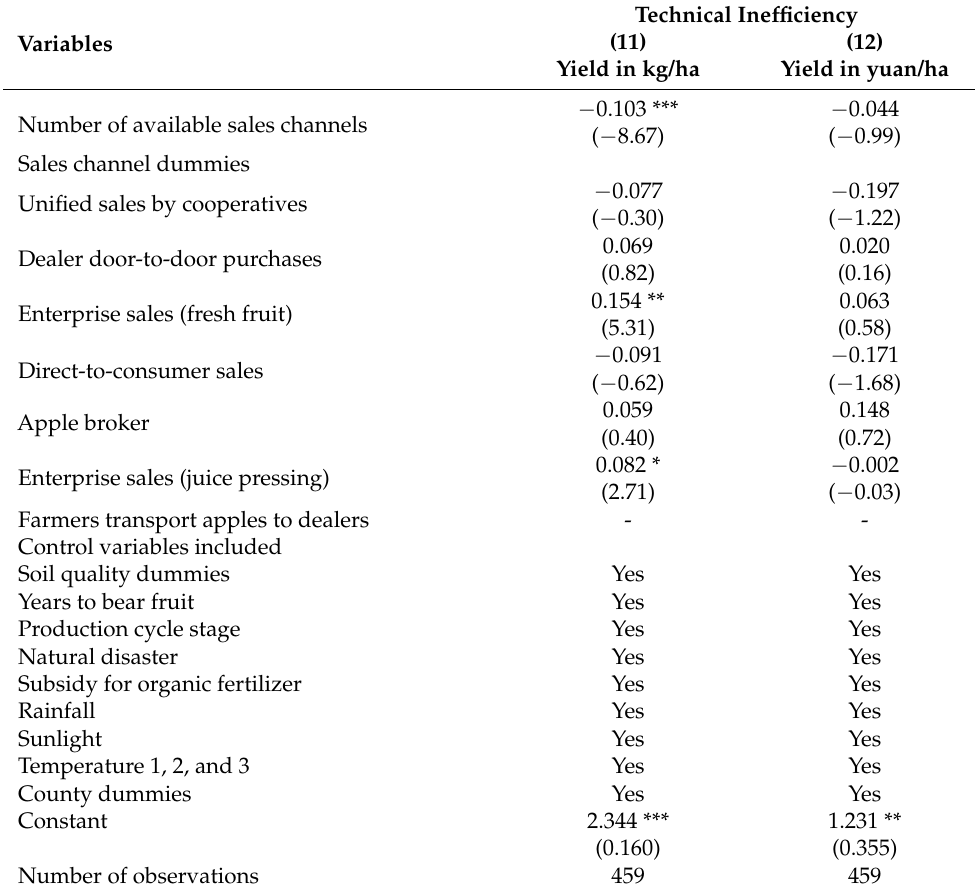
Table 8. Estimated determinants of technical